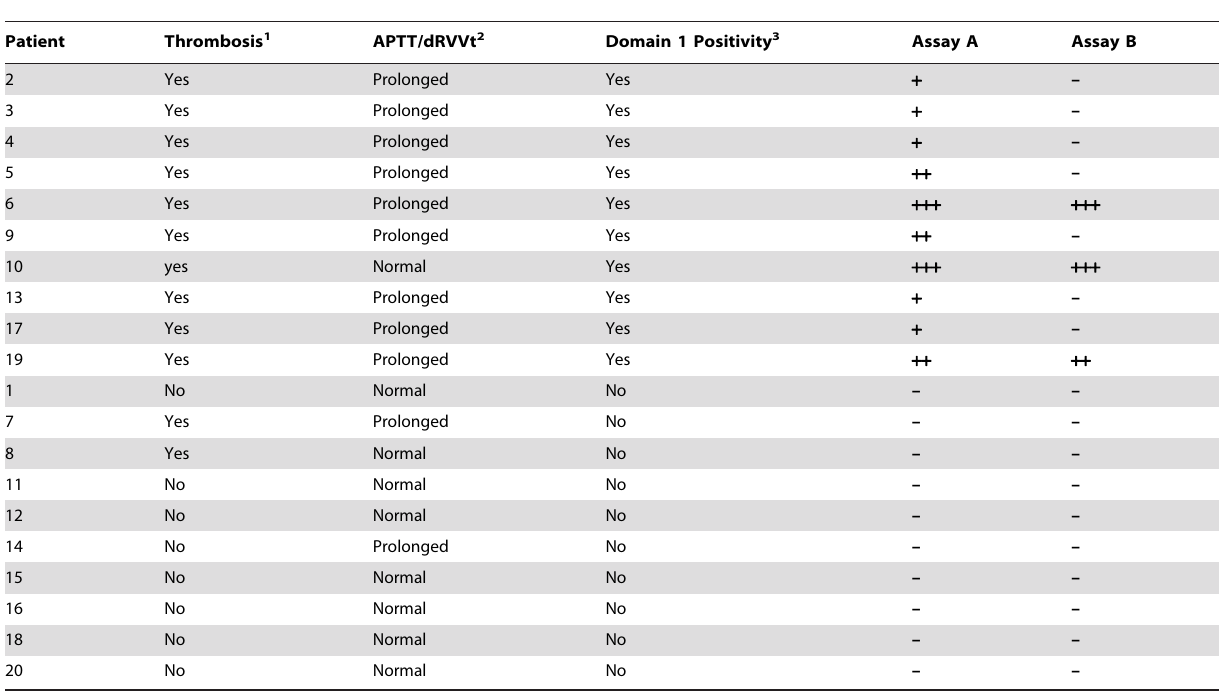
Table 2. Reactivity of patient samples of cohort 1 in two different anti- b 2 GPI assays.